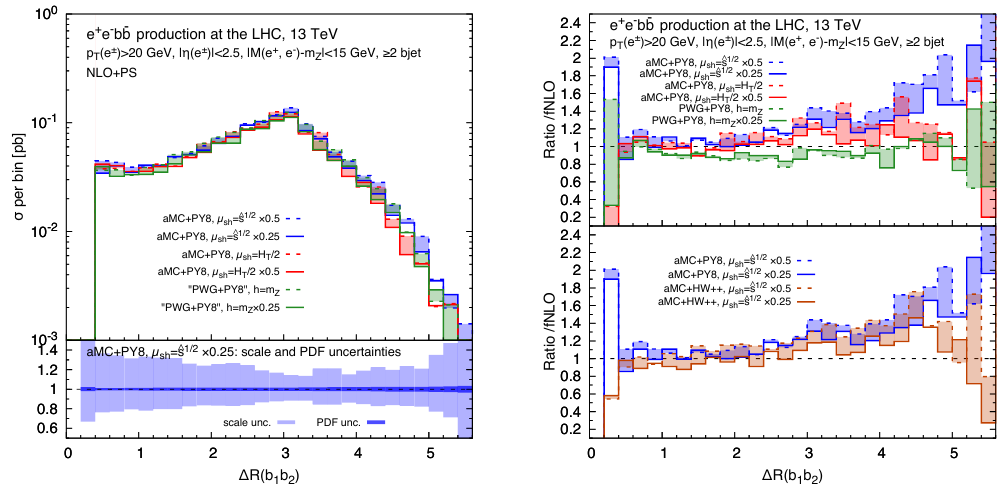
Figure 23 . (cid:1) R distribution of the hardest b -jet